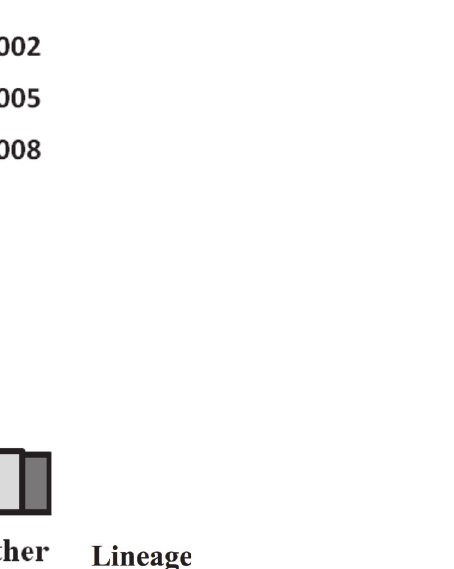
Figure 1. Overview of the dynamic changes in genotype frequencies in all MTB strains isolated from 421